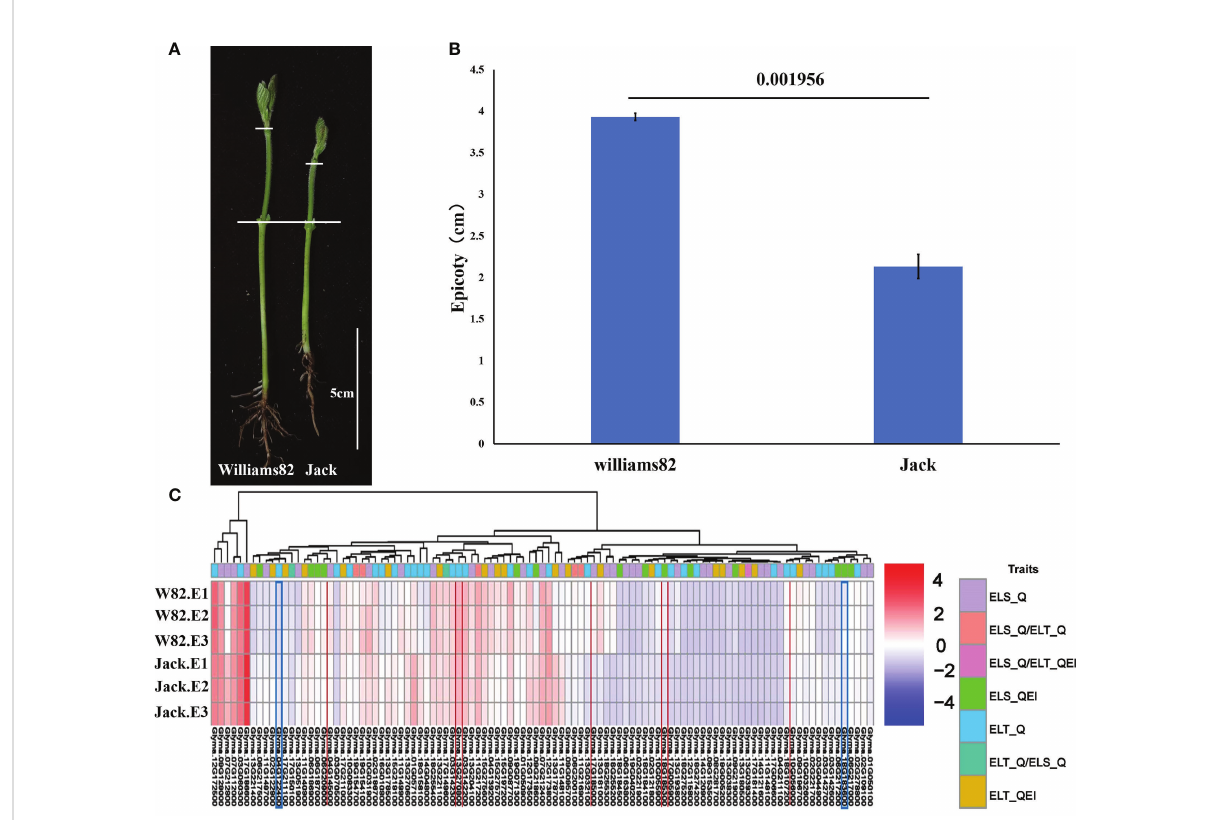
FIGURE 7 Epicotyl length of Williams82 and Jack and expression analysis of 103 candidate genes. (A) Epicotyl phenotype of W82 and Jack (B) Epicotyl Length Analysis of W82 and Jack (C) Transcriptome alignment of 103 candidate